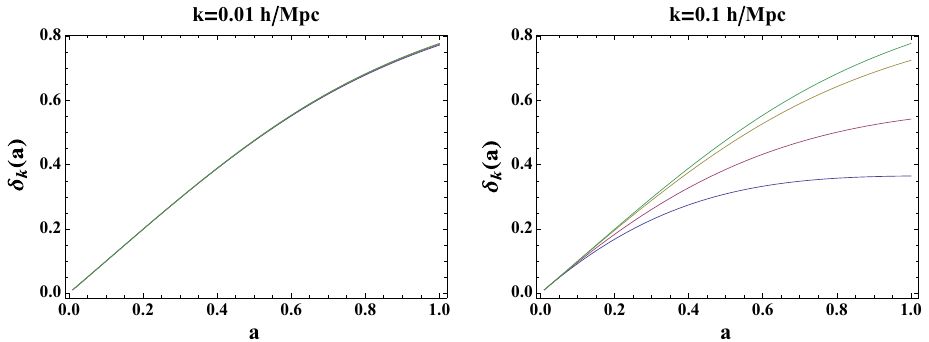
Fig. 3 The scale-dependence of linear gravitational clustering is illus- trated for a non-canonical model with V (φ) = (cid:4)/ 8 π G . The linear density contrast, δ , is shown as a function of the expansion factor, a ,